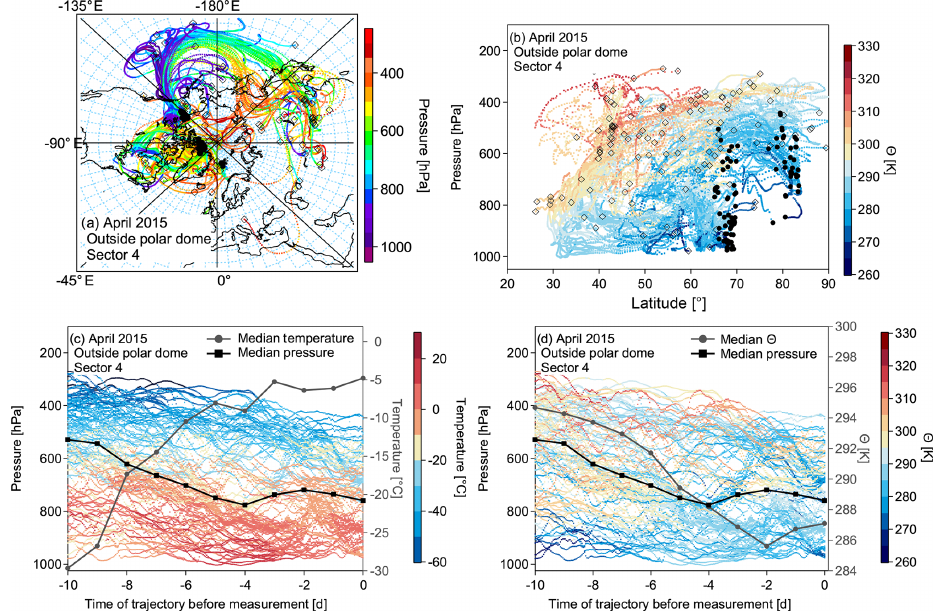
Figure 13. (a) Trajectories of the most dominant sector 4 for air masses outside the polar dome. The color code represents the pressure along the trajectories. (b) The same trajectories as in (a) as a function of pressure and latitude, color coded by potential temperature. In both (a) and (b) black circles denote the initialization point of the trajectory along the flight track. The black open squares show the position of the trajectory 10d back in time. Panels (c) and (d) show height–time cross sections with pressure representing the altitude of the trajectories (left axis) for the trajectory evolution over the 10d of travel, with the color code denoting the temperature (c) and potential temperature (d) . The black line marks the median pressure of the trajectory cluster at the individual time steps, and the grey line indicates the median temperature and median potential temperature, respectively. Note that only every 20th trajectory is plotted for figure clarity. Table 3. Mean and median mixing ratios of CO and CO 2 inside and outside the polar dome area using the tracer-derived polar dome boundaries. The respective mixing ratios were calculated based on the minimum latitude and maximum potential temperature coordinates. Note that for the July 2014 dataset the mixing ratios of the mixing region (MR) are also included in the